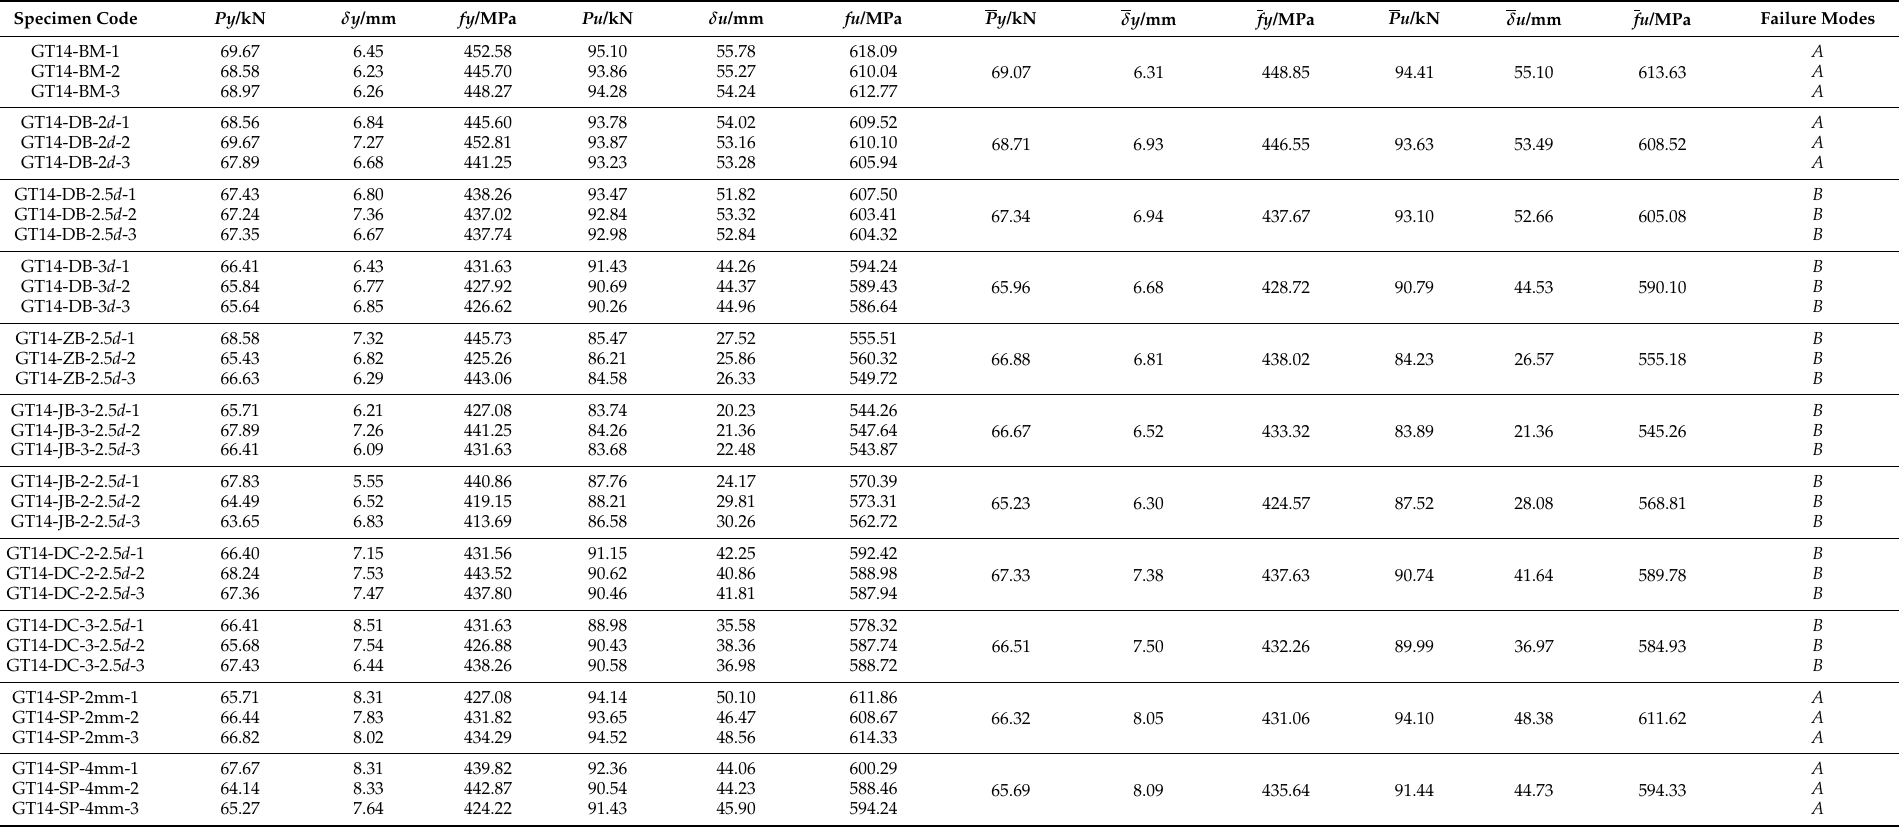
Table 9. Characteristic points and failure modes of the